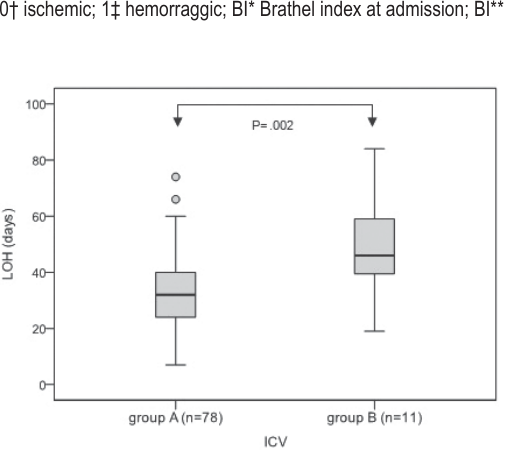
0† ischemic; 1‡ hemorraggic; BI* Brathel index at admission; BI** Barthel index at